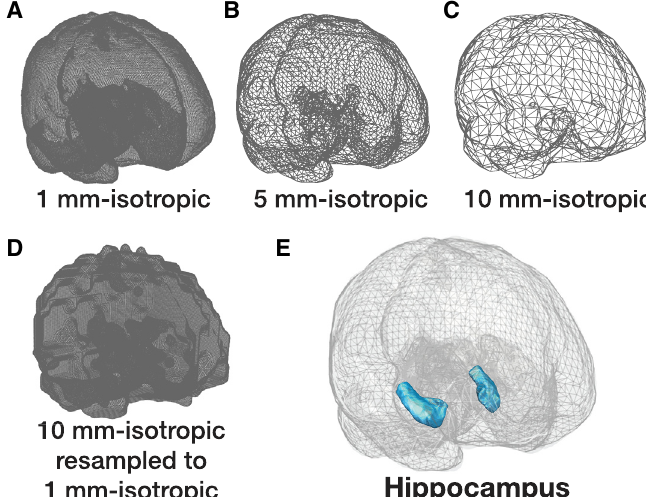
Figure 6. Wireframes of brain images of different resolutions. ( a ) Wireframe rendering of brain surface mesh produced from the Hammers et al. (2003) atlas, which originally has voxel size of 1 mm-isotropic. Panels B - C show the wireframes of surfaces meshes made after first downsampling the volume to 5 or 10 mm-isotropic, respectively, resulting in less dense wireframes. ( d ) For demonstration purposes, the result of upsampling the 10 mm-isotropic mesh (panel C) back to 1mm-isotropic. ( e ) Rendering produced by combining the surface meshes used in panels A-C, along with an anatomical ROI of the hippocampus.